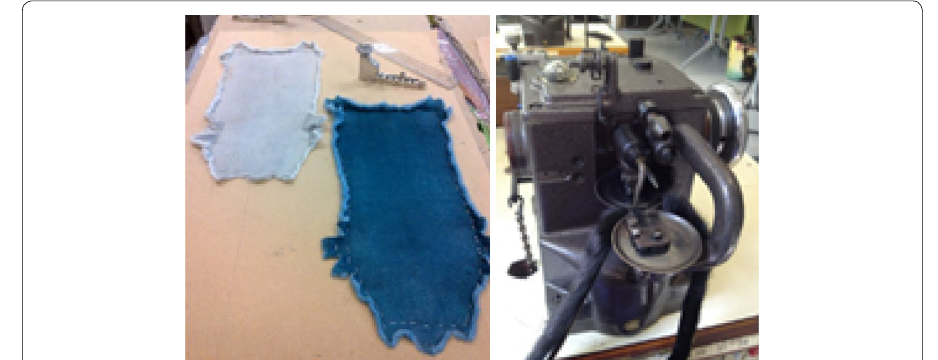
Fig. 2 Working process for fur design development, photographed by the